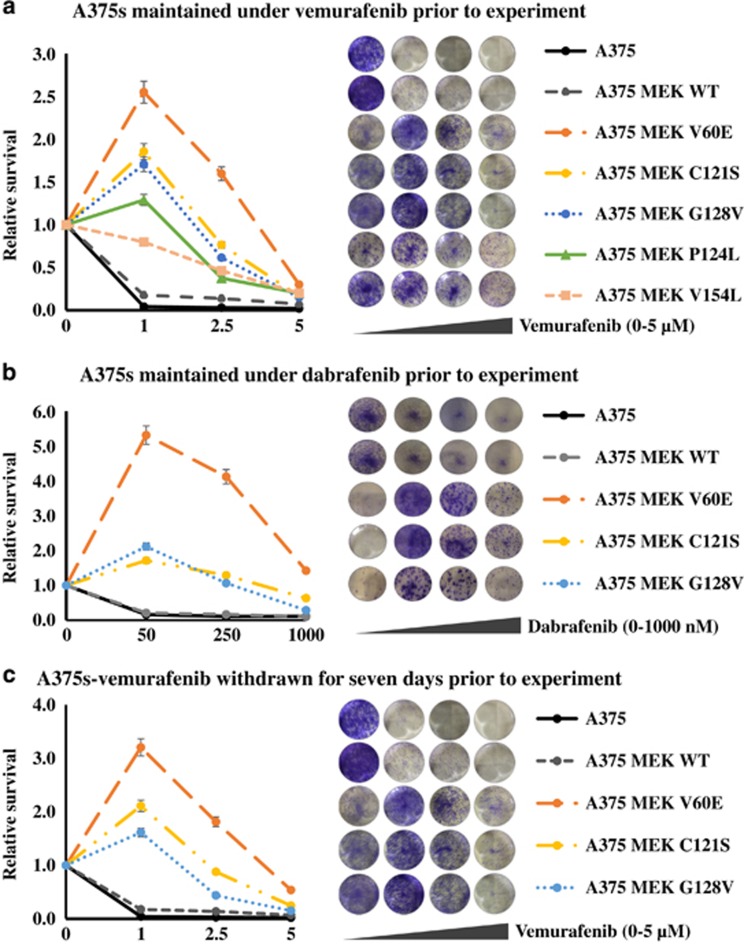
BRAF melanoma cells with MEK mutations are addicted to BRAF inhibition. (a) Melanoma cells infected with wild-type MEK, MEKIndel55RT, MEKQ56P, MEKV60E, MEKC121S, MEKG128V, MEKP124L, MEKV154L or empty vector controls were maintained under 1 μm vemurafenib and treated with the indicated dosage of vemurafenib. (b) Cells were maintained under 50 nm dabrafenib and treated with the indicated dosage of dabrafenib. (c) Cells were maintained under 1 μm vemurafenib for 2 weeks followed by 7 days of withdrawal, then treated with the indicated dosage of vemurafenib. All experiments were performed in triplicate; representative wells at the escalating doses are shown to the left of the figure legend.